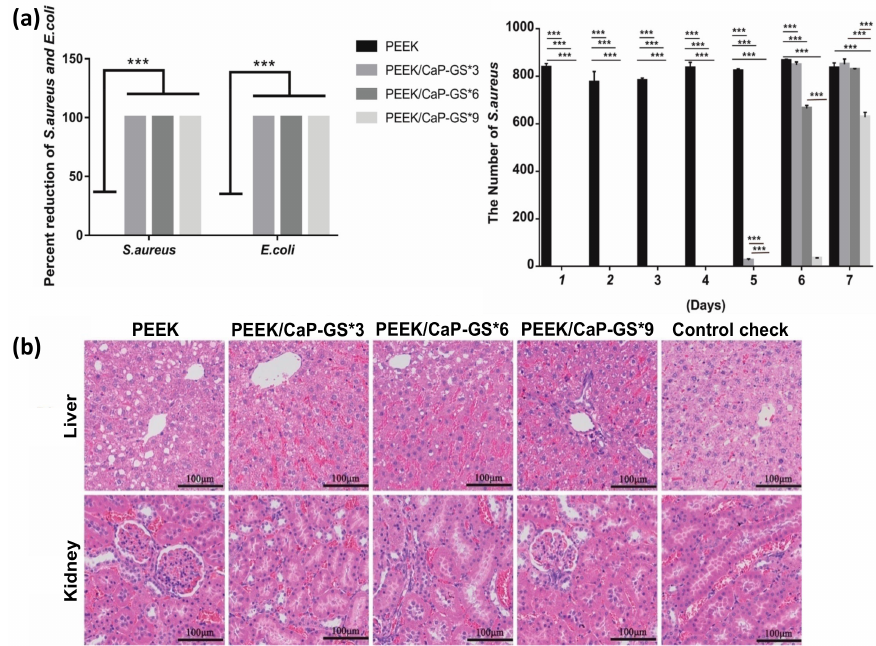
Figure 13. PEEK surface modification using layer-by-layer technique. Xue et al. showed ( a ) antibacte- rial properties against S. aureus and E. coli and ( b ) in vivo histological analysis (scale bar: 100 µ m) of LbL-modified PEEK surfaces. PEEK = untreated PEEK. PEEK/CaP-GS* n ( n = 3, 6, 9) = PEEK layered with n layers of brushite containing antibiotic gentamicin sulfate. Control check = blank [154]. LbL-(brushite-gentamicin)-modified PEEK surfaces enhanced antibacterial and osseointegration properties. (*** The differences were considered statistically significant at p < 0.001). All figures were reprinted with permission from the literature